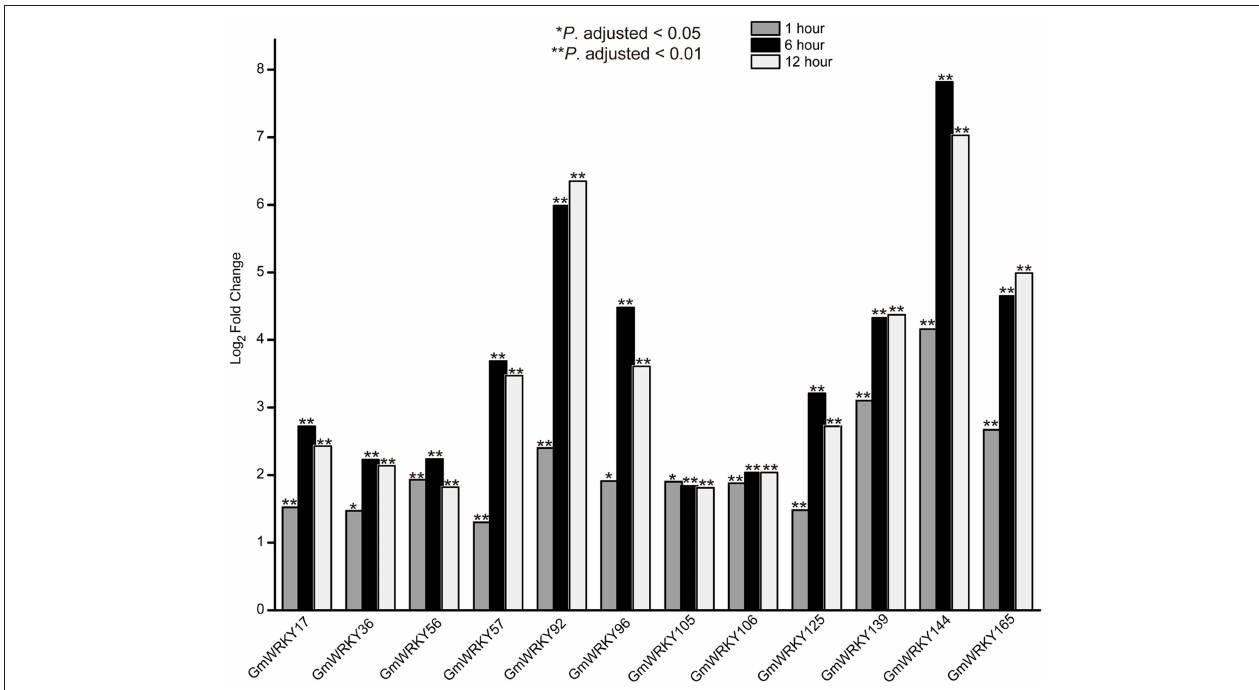
FIGURE 9 | Different expression of GmWRKY genes in three time point under salt stress based on RNA-seq data.